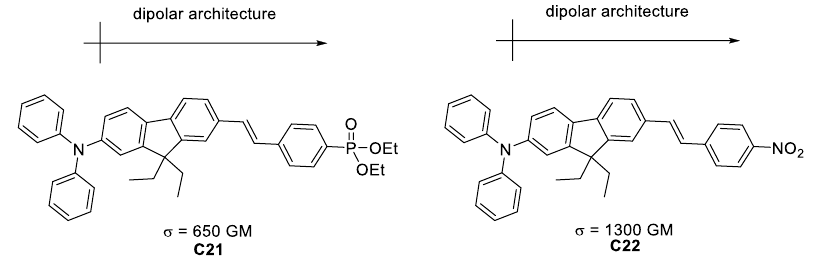
Figure 26. Efficient TPA chromophores designed within the dipolar approach.